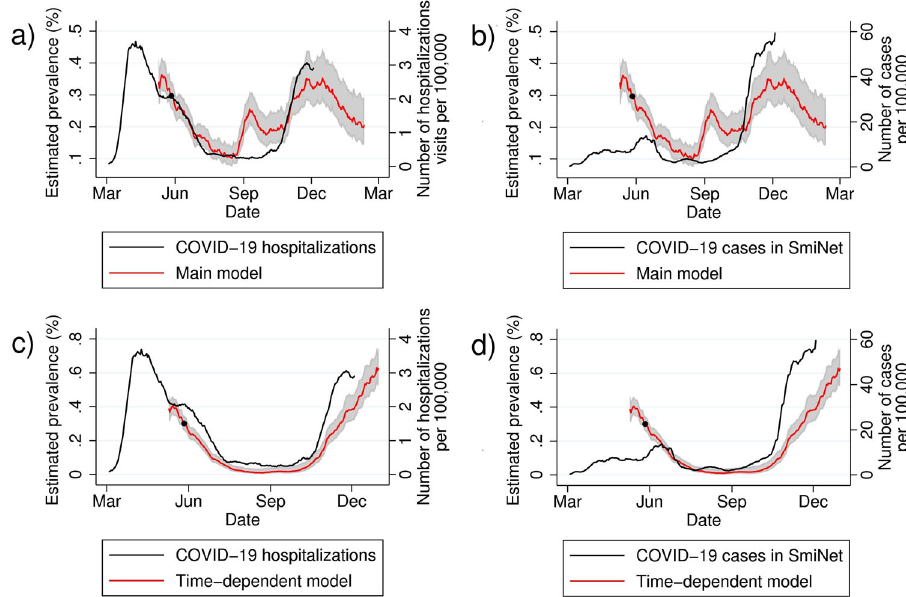
Fig. 3 Prevalence estimates of symptomatic COVID-19 in Sweden. National prevalence estimate, with 95% con fi dence interval, of symptomatic COVID-19 in COVID Symptom Study Sweden (main model utilized for real-time prediction estimates, and retrospective time-dependent model), combined in ( a and c ) with retrospective data on daily number of new hospital admissions registered in the National Patient Register per 100,000 inhabitants ≥ 18 years, and in ( b and d ) with daily number of new COVID-19 cases registered in SmiNet, per 100,000 inhabitants ≥ 18 years. *Time-point for recalibration of CSSS national COVID-19 prevalence estimate using national point prevalence survey fi ndings from the Public Health Agency of